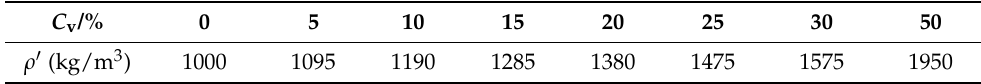
Table 2. Density under different particle volume concentrations.